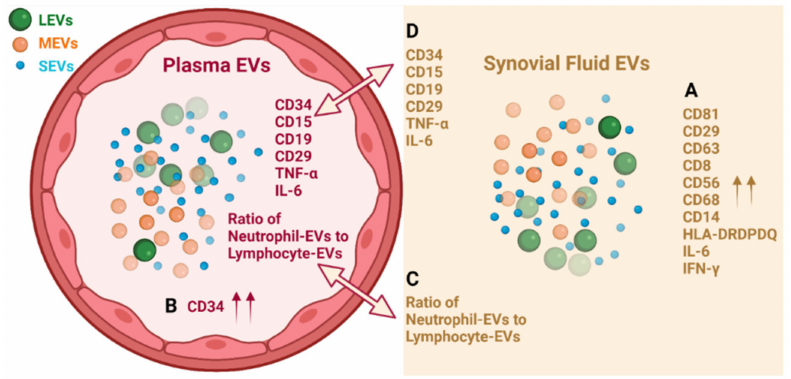
Figure 5. Graphic summary of results. ( A ) Multiple immune cell-derived EV subpopulations were enriched in SF compared with plasma; the pro-inflammatory phenotype of SF EVs was supported by their pro-inflammatory cytokine cargo. ( B ) HSC-, progenitor cell-, and endothelial cell-associated CD34 + EV populations were enriched in plasma relative to SF. ( C ) Ratios of neutrophil-EVs to lymphocyte-EVs were positively correlated between plasma and SF. ( D ) EVs related to several types of stem cells, progenitor cells, neutrophils and B cells, and endo-EV pro-inflammatory cytokines IL-6 and TNF- α were highly correlated between SF and plasma. Graph was created with